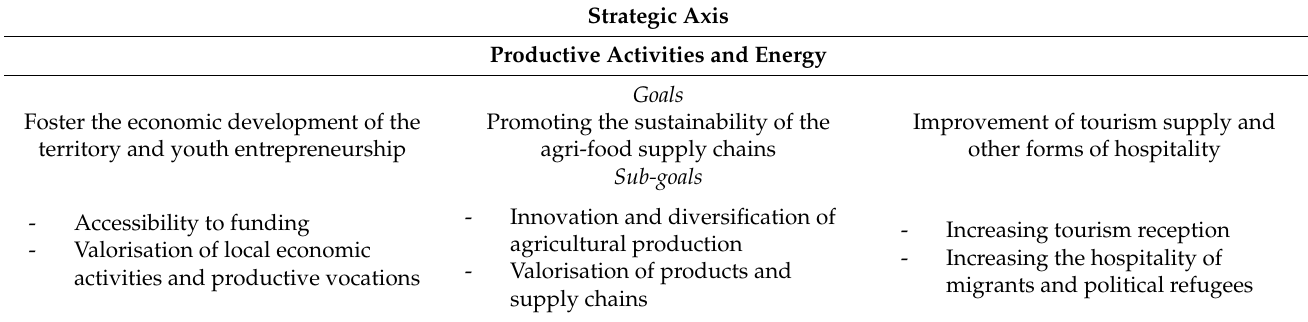
Table 5. Declination of the “Productive activities and energy” strategic axis into goals and